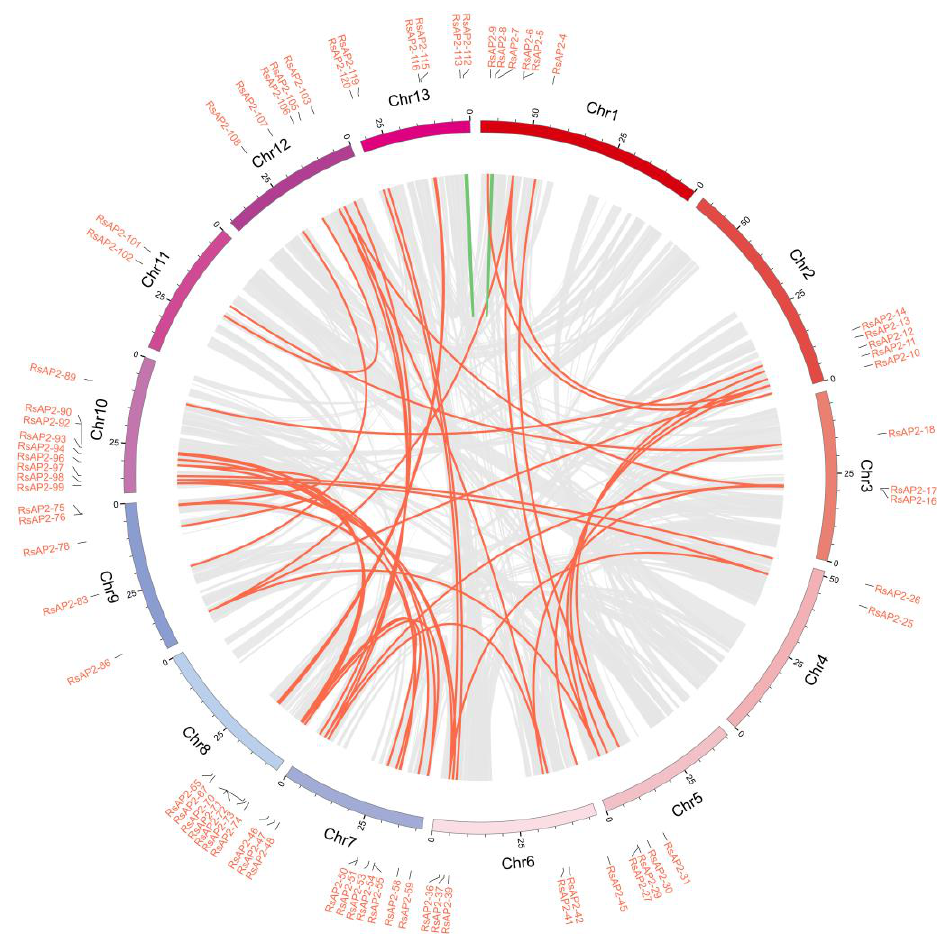
Figure 5. Synteny analysis and chromosomal relationships of Rhododendron RsAP2 genes. Red lines indicate duplicated RsAP2 gene pairs between different chromosomals, green lines indicate duplicated RsAP2 gene pairs in the same chromosomal and gray lines indicate all synteny blocks in the Rhododendron genome.